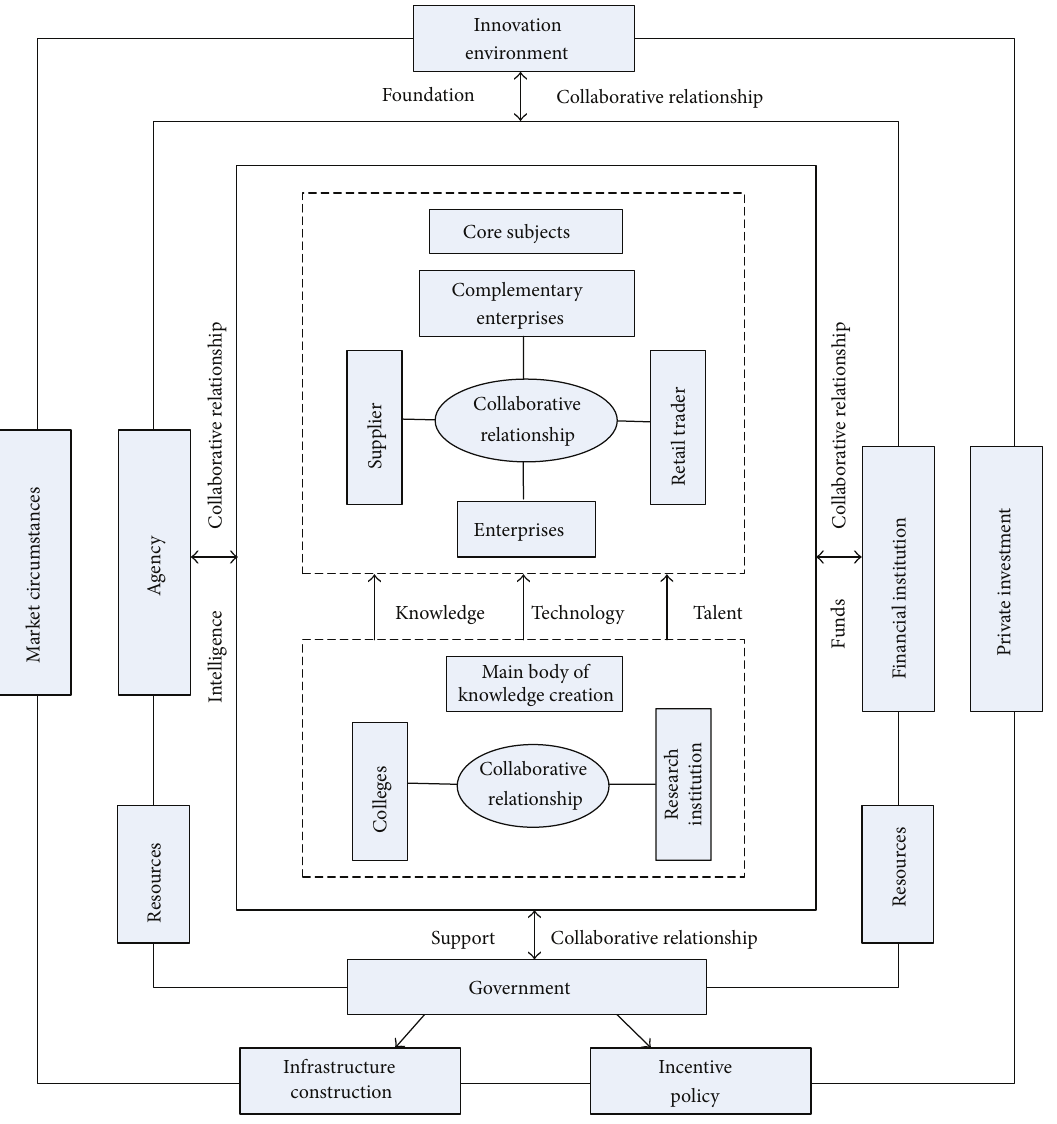
Figure 3: Architecture of the regional innovation system under the collaborative